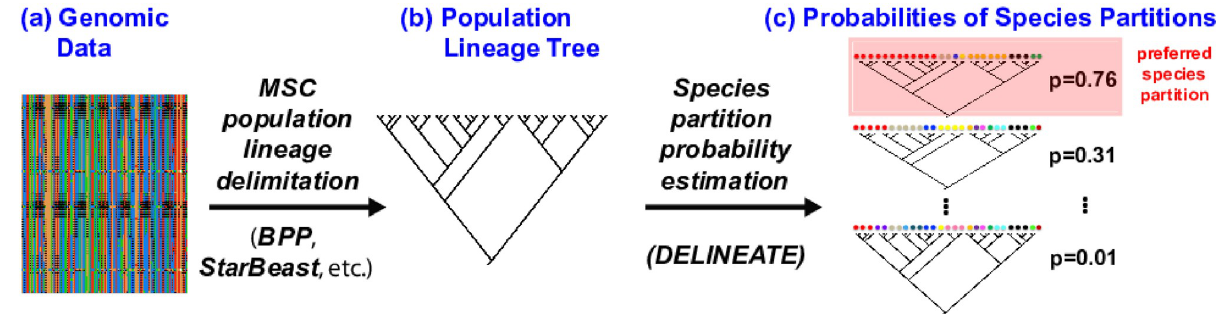
Fig 4. Accuracy of DELINEATE maximum likelihood estimates of speciation-completion rate compared with the true speciation-completion rate; the ribbon shows the minimum and maximum of the 95% confidence interval ranges for the various estimates under that true rate. Note that the population isolation rate was fixed at 0.1, so the range of speciation-completion rates, from 0.001 to 0.1 spans rates from one hundred times slower to equal to the population isolation rate.